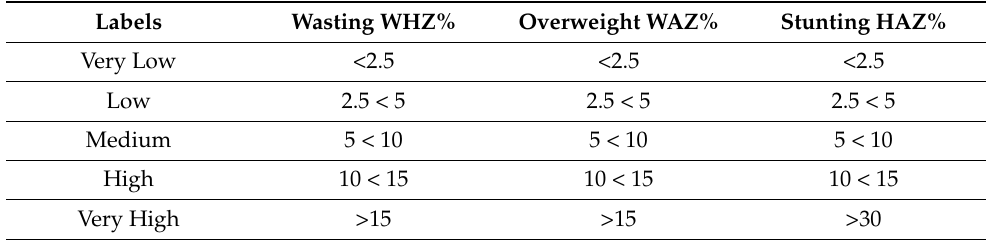
Table 1. Prevalence thresholds for public health significance for wasting, stunting, and overweight in children. Labels Wasting WHZ% Overweight WAZ% Stunting HAZ% Very Low <2.5 <2.5 <2.5 Low 2.5 < 5 2.5 < 5 2.5 < 5